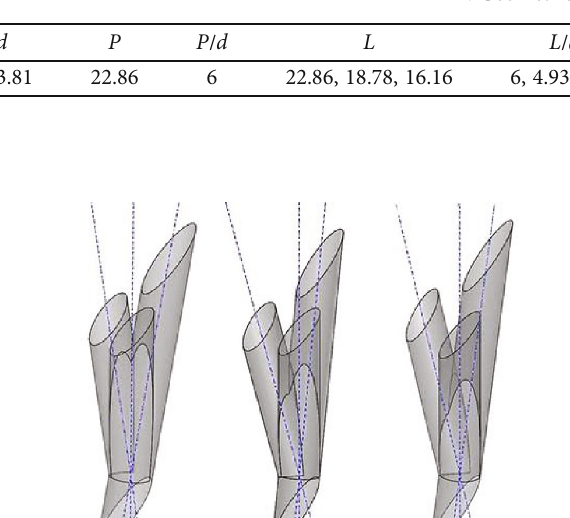
Table 1: Geometric parameters (lengths in